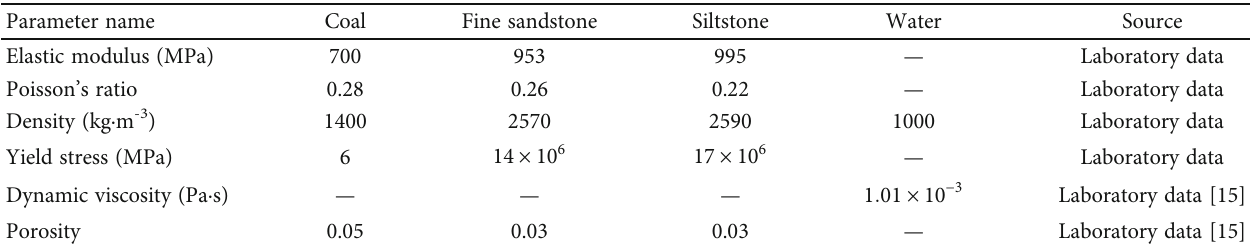
Table 2: Parameter table of the model.